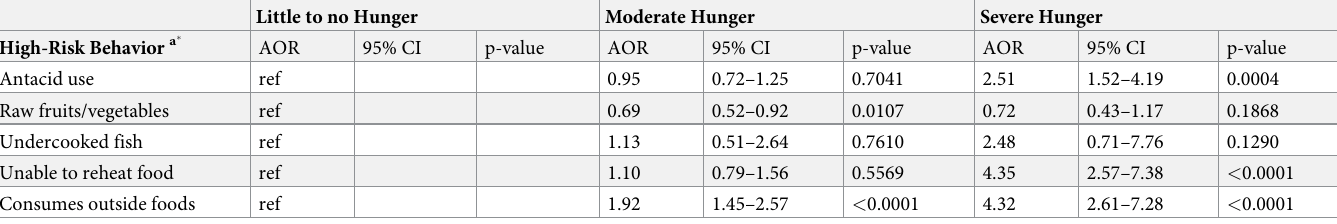
Table 3. Adjusted associations between household food insecurity and behaviors in a cross-sectional study of 1072 households in Mirebalais, Haiti, 2019.